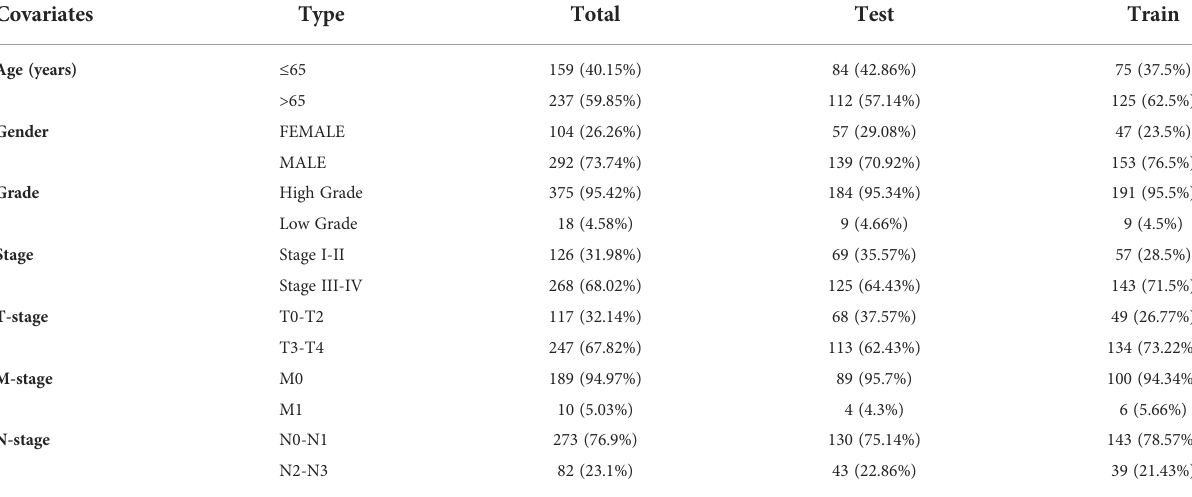
TABLE 2 Clinicopathological parameters of BLCA patients in this research.